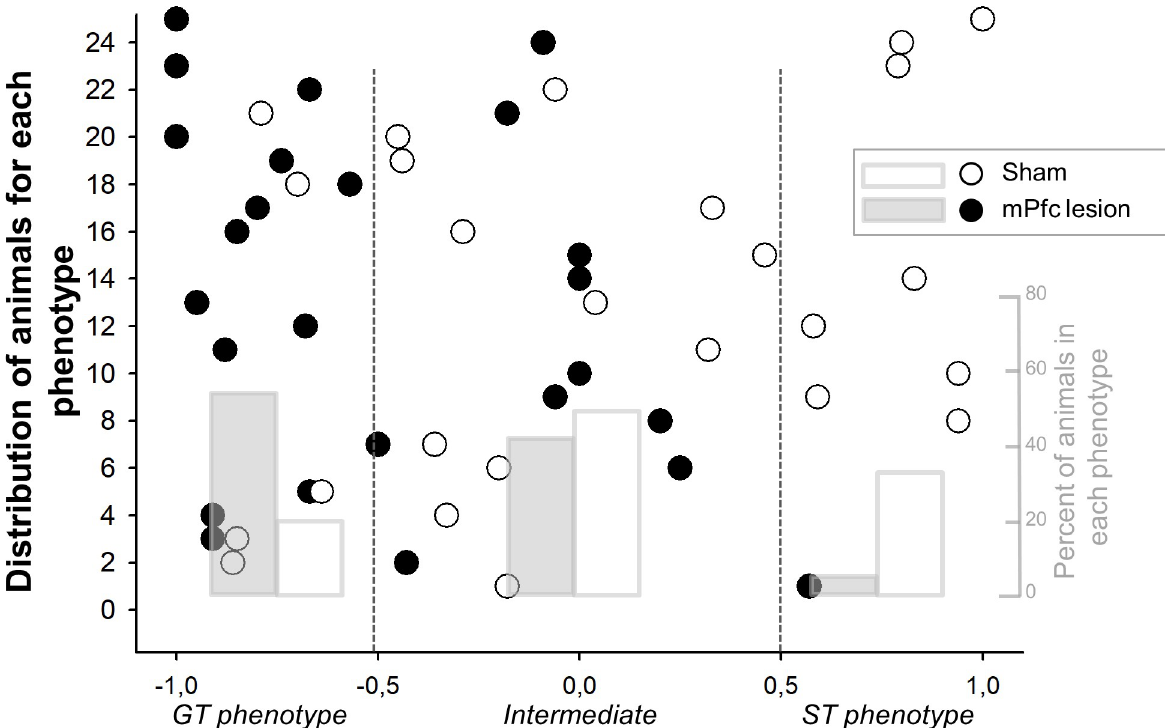
Fig 3. Distribution of GT, ST, or Int phenotypes in sham and mPFC-lesioned animals in session 4. Black and open circles show data from all individual animals. Grey and white bars shows the percent of animals expressing each phenotype.